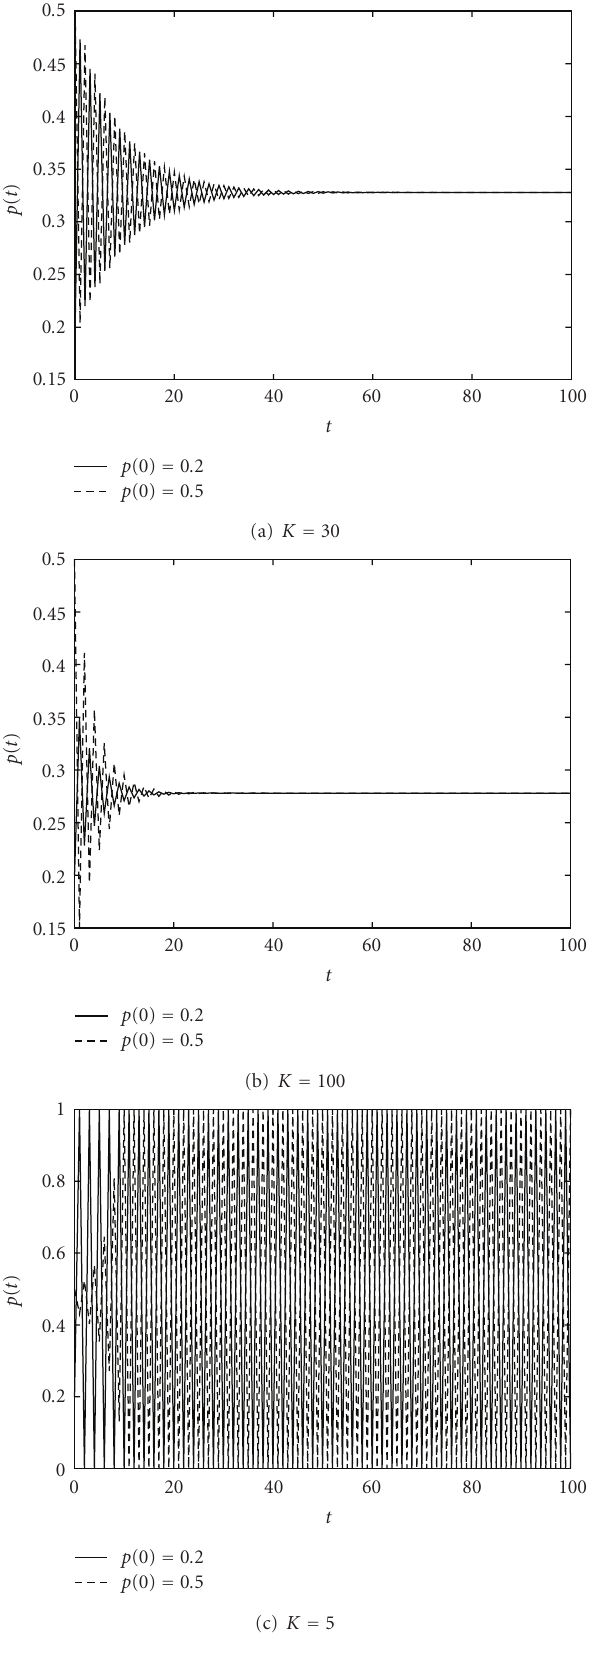
Figure 4: Transient behavior ( α = 1 .